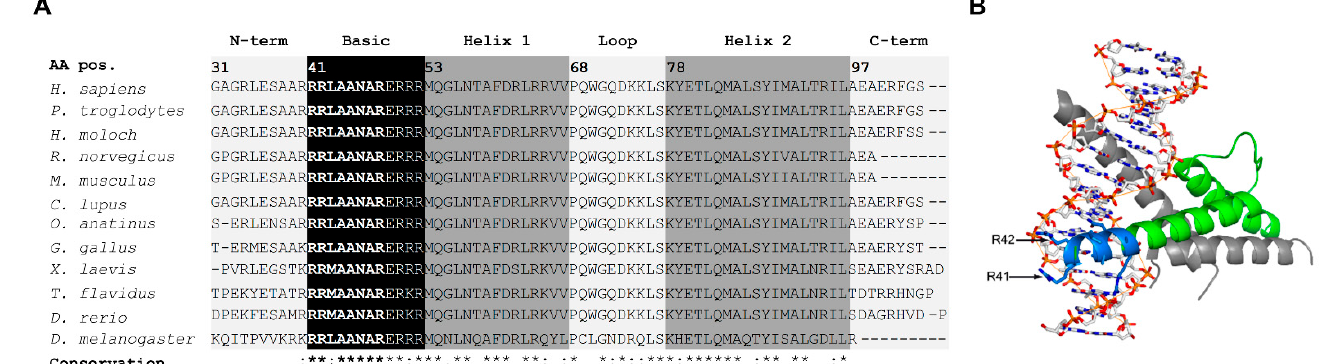
Figure 1. The in-frame deletion ATOH7:R41_R48del predicts the removal of evolutionarily conserved amino acids within the basic domain of ATOH7. ( A ) MSA of bHLH protein sequences of twelve ATOH7 homologs. Seven out of the eight deleted amino acids (in bold) are highly conserved between the investigated species. ( B ) A three-dimensional model of the bHLH structural motif of ATOH7 (blue, deleted basic domain positions Arg41–Arg48; green, remaining bHLH motif) dimerized with the transcription factor E47 (grey) and bound to dsDNA. The deleted amino acids within the ATOH7 basic domain are in close connection to the major groove of the DNA helix. Asterisk (*), fully conserved amino acid residue; colon (:), amino acid residues with strongly similar properties; period (.), amino acid residues with weakly similar properties. AA pos, amino acid position; ATOH7, atonal bHLH transcription factor 7; bHLH, basic helix–loop–helix; C-term, C-terminus; dsDNA, double-stranded DNA; E47, transcription factor 3 isoform E47; MSA, multiple sequence alignment; NCRNA, nonsyndromic congenital retinal nonattachment; N-term, N-terminus.